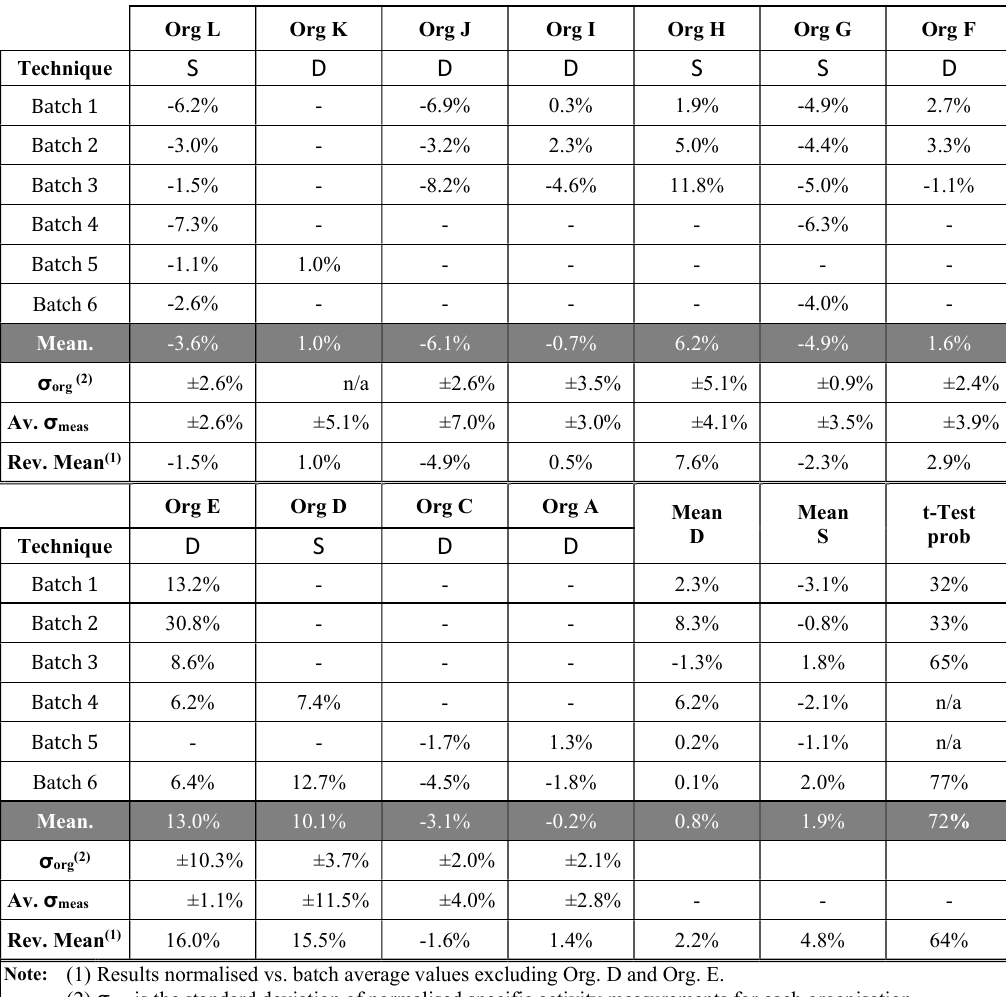
Table 3 Normalised Specific Activity